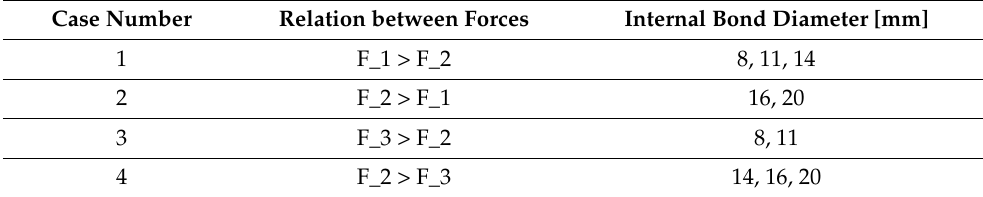
Table 2. Relation between forces for “S” group.